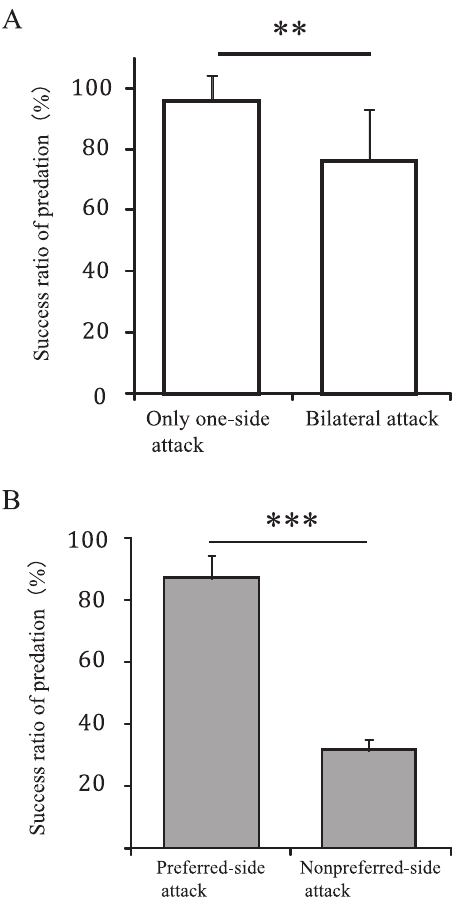
Figure 3. Comparison of predation success. (A) The success ratio of predation (mean 6 SD) by fish that attacked only on one side (N=13) and fish that attacked bilaterally (N=7). (B) Weighted means of the predation success ratio for preferred- (N=20) and nonpreferred-side attacks (N=7). The weighted mean ratio is the value-weighted average of the ratios in which weight is proportional to the number of prey attacks. Error bars indicate 95% confidence intervals. P-values are from the Wilcoxon signed-rank test and GLMM analysis, respectively. **p , 0.01, ***p , 0.001.